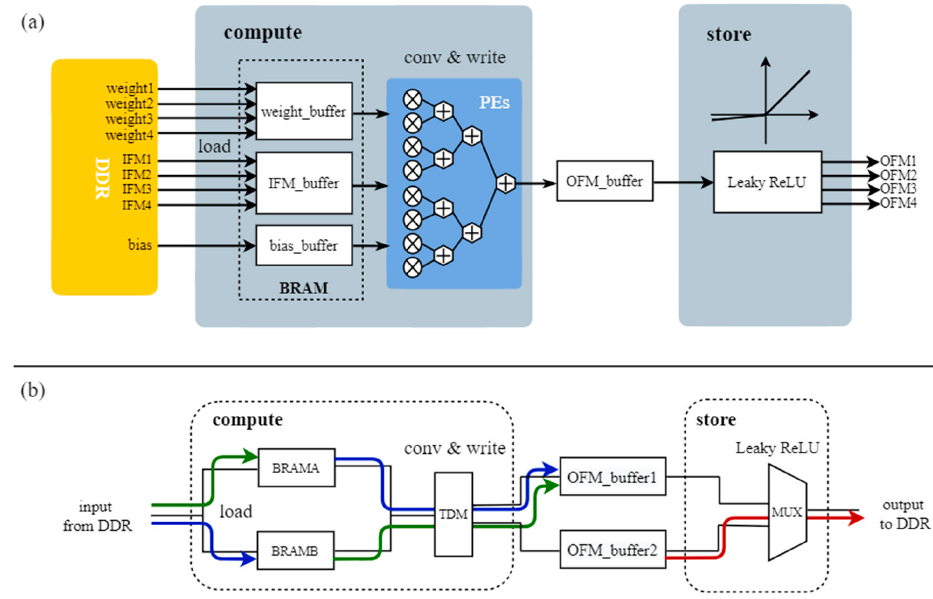
Figure 6. ( a ) Internal architecture of the FPGA accelerator. ( b ) The two-layer ping-pong design. For the two-layer ping-pong operation, the accelerator fi rst caches the DDR input to BRAMA and BRAMB, then performs ping-pong operations on load and convolve and write, and writes the result to one of the OFM_bu ff ers in the form of time division multiplexing (TDM) to complete the compute module, as shown in the blue and green lines in Figure 6b. At the same time, we perform coarse-grained ping-pong between the compute module and the store module, i.e., while the compute module writes to OFM_bu ff er1, the result of the previous calculation cache is read out from OFM_bu ff er2 to DDR, as shown in the red line in Figure 6b. The work of the red line, blue line, and green line is carried out simultaneously, allowing fi ne-grained ping-pong within modules and coarse-grained ping-pong between modules to be performed at the same time. Thus, from the DDR side, data is sent out and in without interruption, and from the BRAM side, the utilization of on-chip resources is greatly improved. 4.3.2. Detail Design of Convolution Kernel Convolutional operations account for more than 90% of computation in most neural networks [36]. Therefore, accelerating the convolutional operations can signi fi cantly re- duce the processing latency of the entire network. Since FPGA on-chip storage resources are very limited and the weights of the convolutional neural network and the feature maps of the intermediate computation results have large storage footprints, it is obviously im- practical to cache the entire feature maps, so we adopt a loop tiling strategy. Suppose the input feature map I is of size N×R×C, the weight W is of size M×N×K×K, the output fea- ture map O is of size M×R×C, and the block factors for the input channel, output channel, and output feature map height and width are Tn, Tm, Tr, Tc. After each block is computed, the next block of input features and weights is then read for computation.